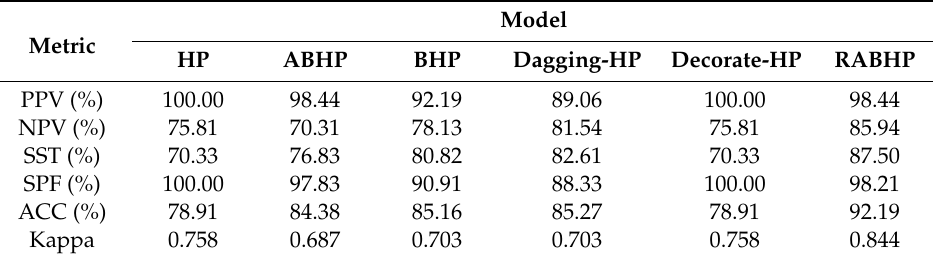
Table 2. Model performance over the training phase.